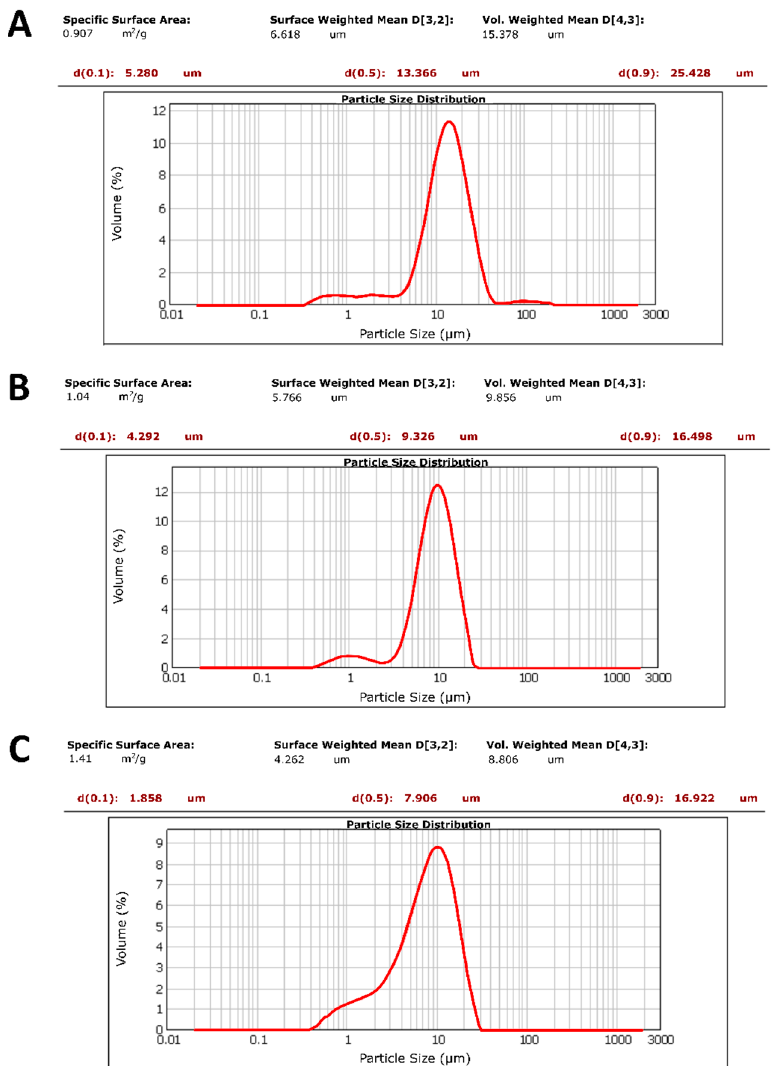
Figure 3. CUR–MPs dimensional analysis by Mastersizer at 3 mg/mL in water solution: ( A ) CUR–oil, ( B ) CUR–water and ( C ) CUR–NE microparticles.